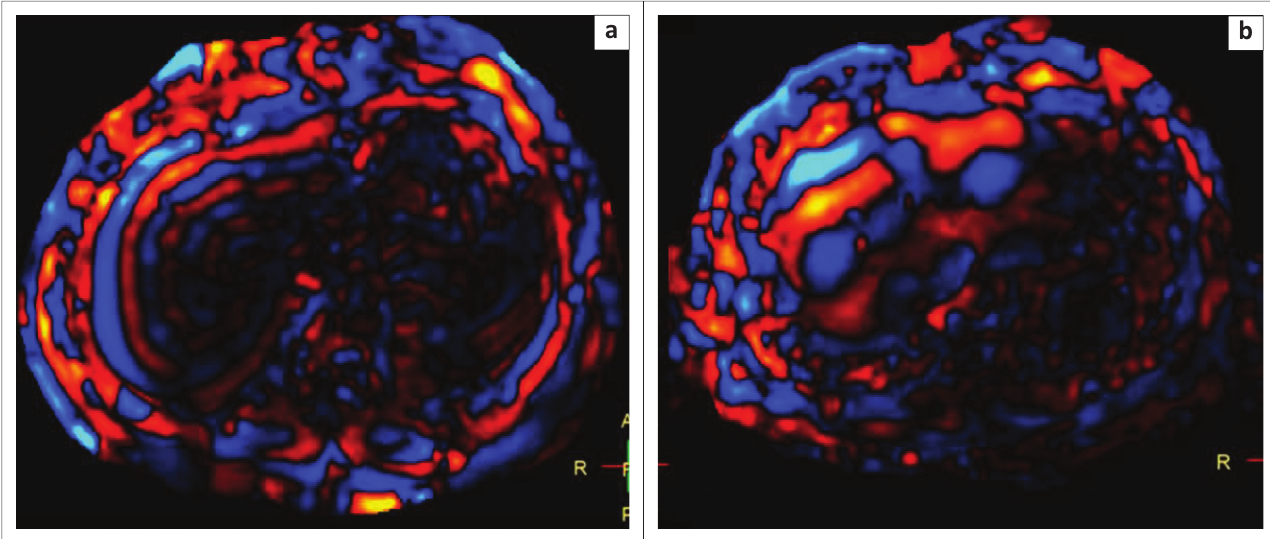
FIG URE 5: Wave images of a patient with a normal liver stiffness measurement (a) and raised liver stiffness measurement (b) show darker medial waves in the patient with a normal liver stiffness measurement as compared to the patient with a raised liver stiffness